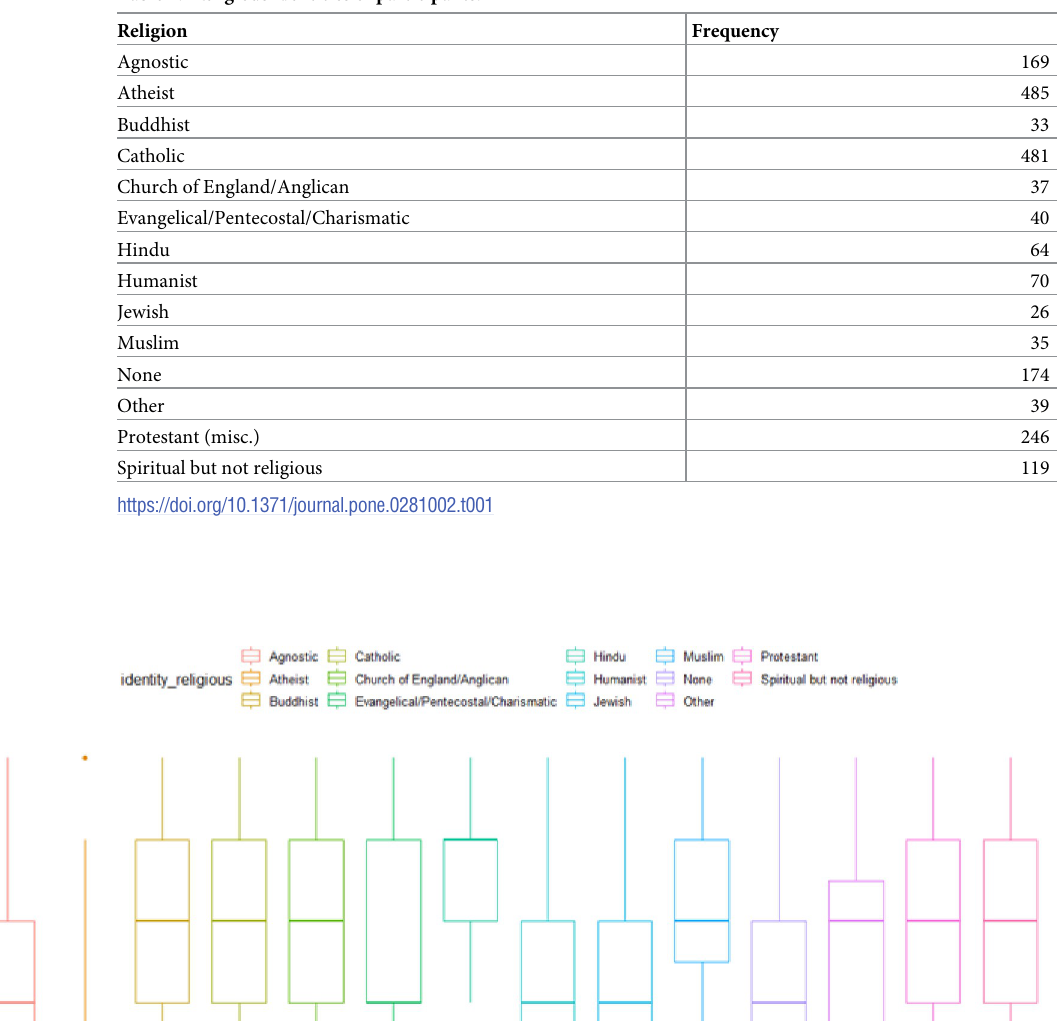
Table 1. Religious identities of participants.